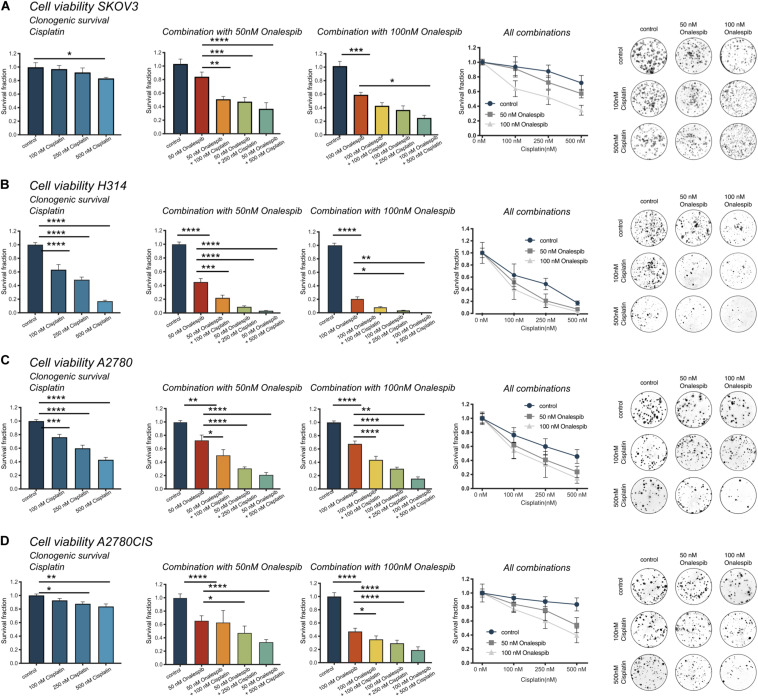
(A) Clonogenic survival of SKOV3 cells treated with 0, 100, 250, and 500 nM cisplatin as monotherapy or in combination with 50 or 100 nM onalespib. Note that combination samples are normalized to 0, 50, or 100 nM of onalespib to compensate for the effect on survival by onalespib alone. (B) Clonogenic survival of H314 cells treated with 0, 100, 250, and 500 nM cisplatin as monotherapy or in combination with 50 or 100 nM onalespib. Note that combination samples are normalized to 0, 50, or 100 nM of onalespib to compensate for the effect on survival by onalespib alone. (C) Clonogenic survival of A2780 cells treated with 0, 100, 250, and 500 nM cisplatin as monotherapy or in combination with 50 or 100 nM onalespib. (D) Clonogenic survival of A2780CIS cells treated with 0, 100, 250, and 500 nM cisplatin as monotherapy or in combination with 50 or 100 nM onalespib. Note that combination samples are normalized to 0, 50, or 100 nM of onalespib to compensate for the effect on survival by onalespib alone. N = 3, error bars represent SD. *p < 0.05, **p < 0.01, ***p < 0.001, ****p < 0.0001.